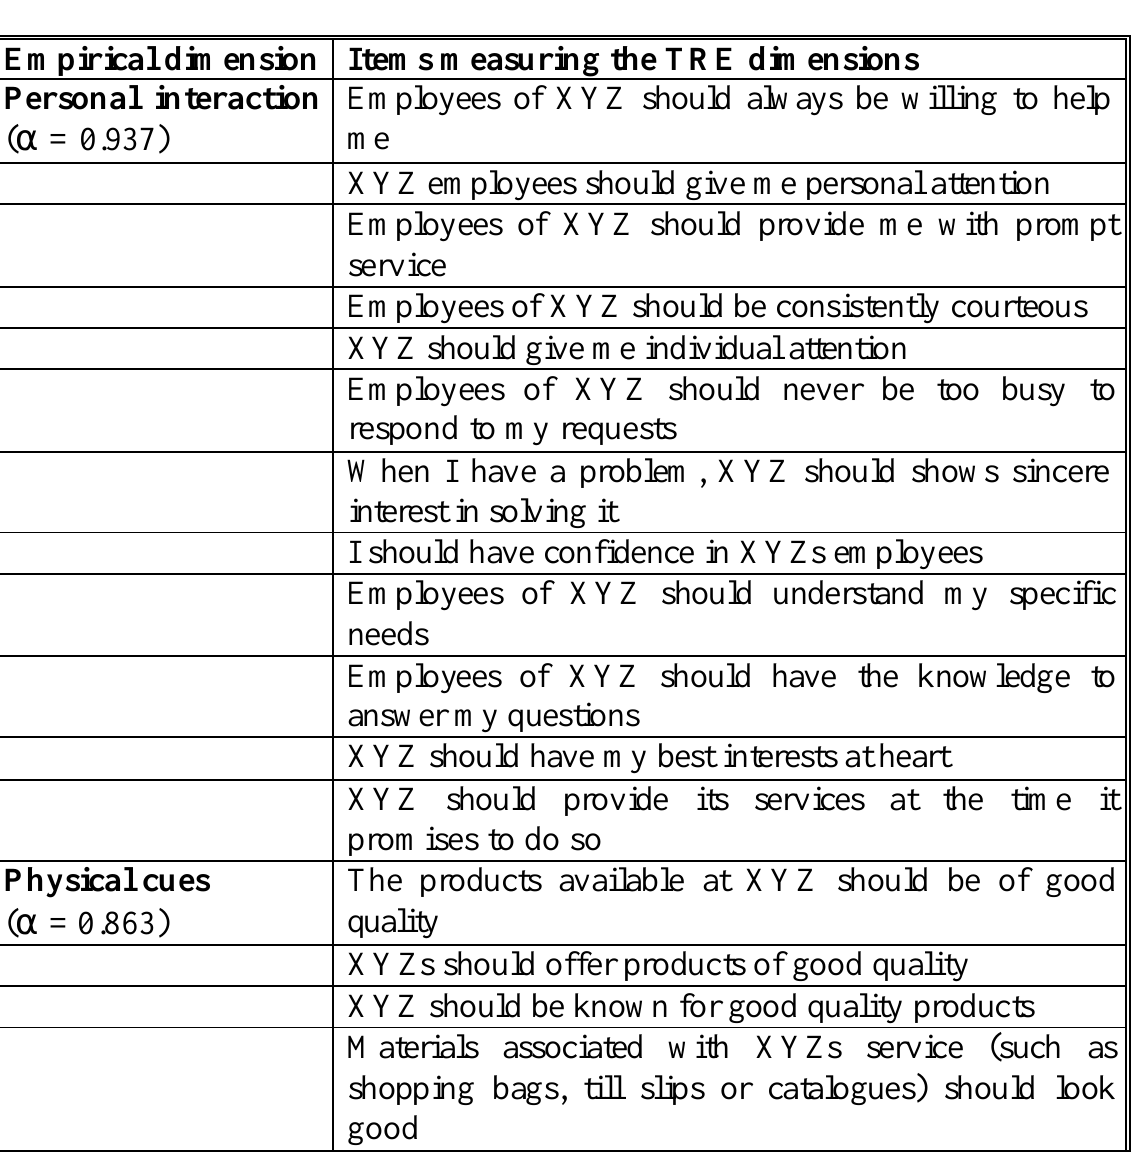
Empirical factor structure: Survey